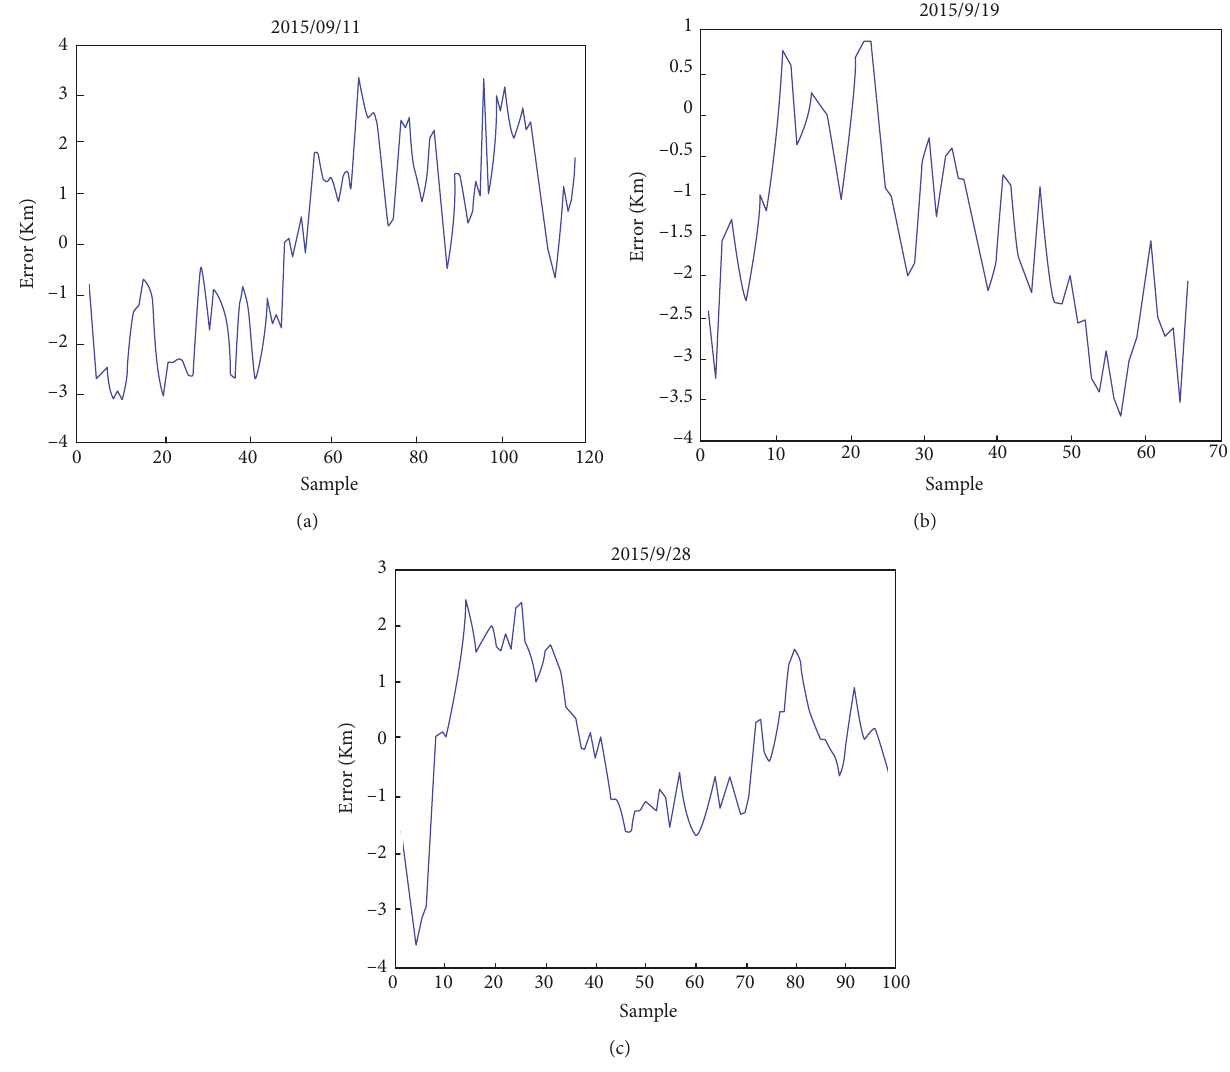
Figure 2: The residual error sequence chart of No. 15 BEV.